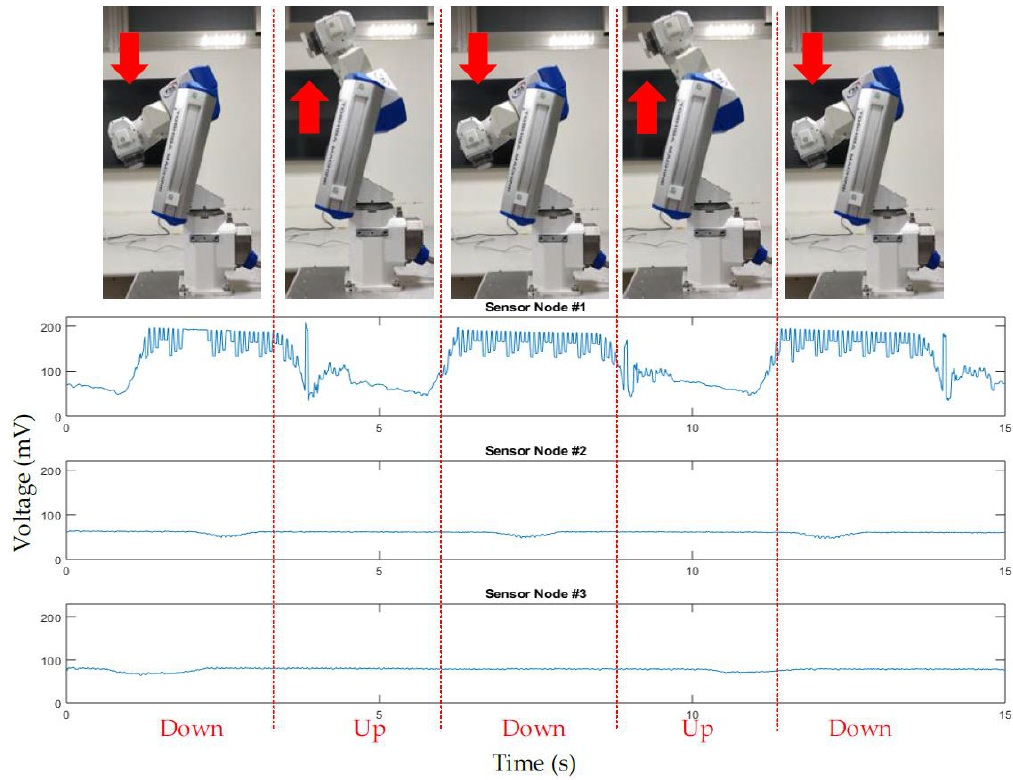
Figure 13. The results of on-site system testing.